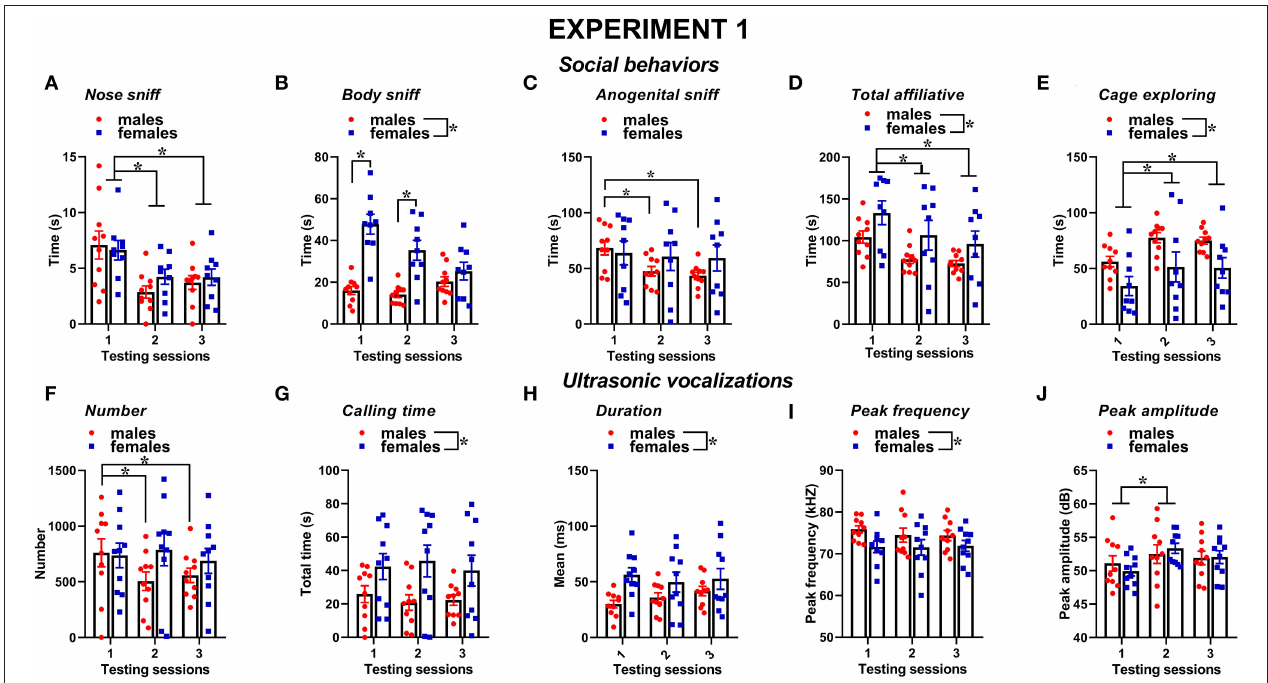
FIGURE 2 | Sex differences in social behaviors and USVs in experiment 1 (same pre-testing isolation). All behaviors were scored in the male and female experimental B6 subjects (A–E) toward a female CD1 stimulus during 3 testing sessions of 3min each (inter-session interval: 7–10 days). Time spent performing social behaviors and cage exploration was scored from video files by an observer who was unaware of the sex of the subjects and their experimental assignment. Affiliative behaviors refer to all sniffing + crawl under/over + allogrooming (refer also to definitions in the text). Cage exploration refers to locomotion in the testing cage and wall rearing. USVs were quantified by spectrographic analysis using the software Avisoft SASLab Pro (F–J) . They were emitted either by male or female experimental B6 subjects toward a female CD1 stimulus during the 3 testing sessions of 3min each. Data are mean ± SEM. N = 10 before exclusion of statistical outliers by Grubb’s test for small samples.* p < 0.05. * Refers to a nonsignificant tendency (0.05 < p ≤ 0.09). Sex differences are reported as * in each graph legend when a significant main effect of sex was detected in the absence of any interaction with testing